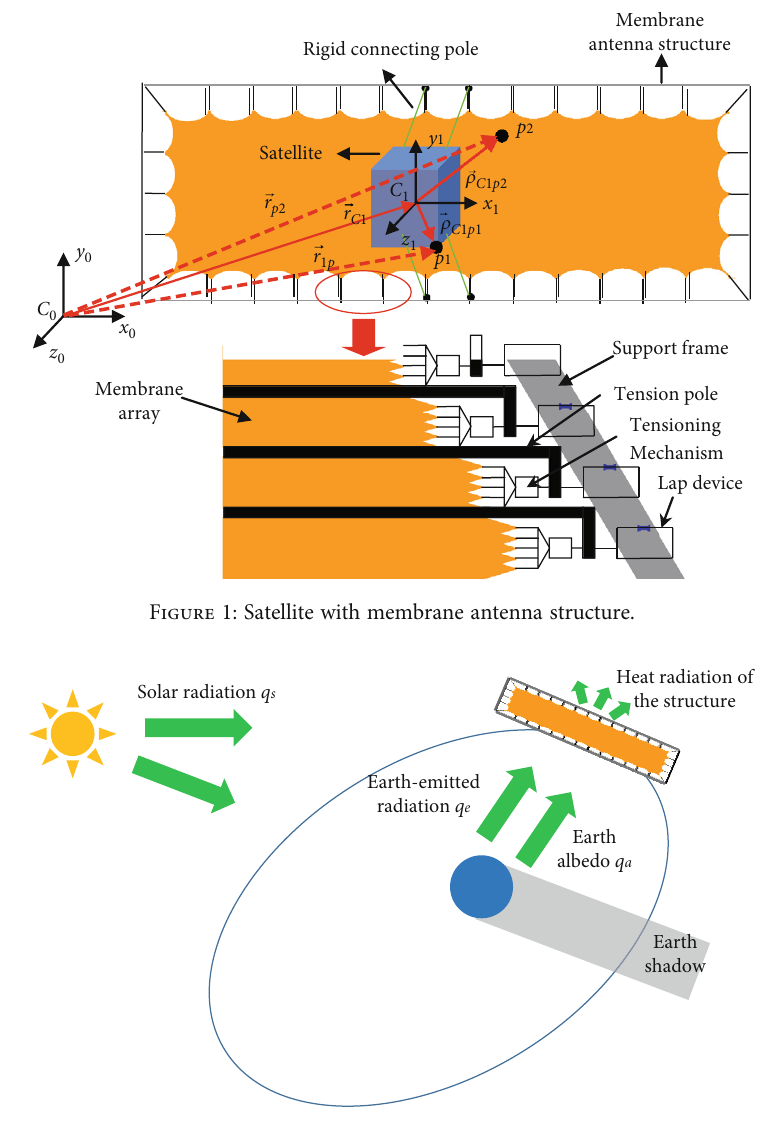
Figure 2: Thermal environment in Earth orbit.